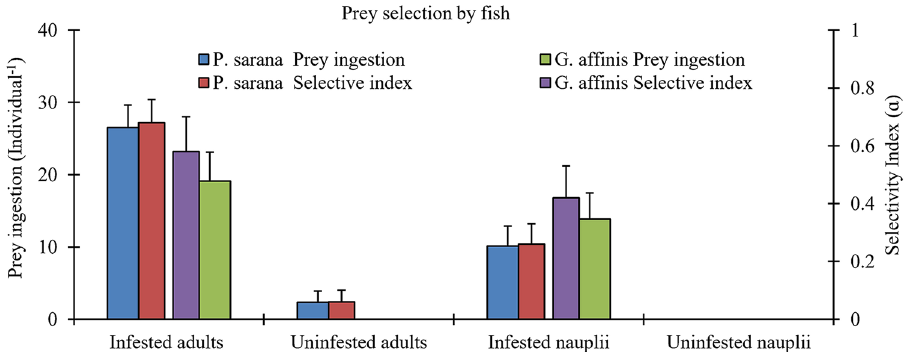
Figure 6. Prey ingestion rate and prey selectivity index value ( ɑ ) for fish Punitus sarana and Gambusia affinis given a choice of colonised (burden level for adults: 21.6 ± 3.06; for nauplii 6.3 ± 2.01 epibionts Individual −1 ) and uncolonised adults and nauplii of Mesocyclops